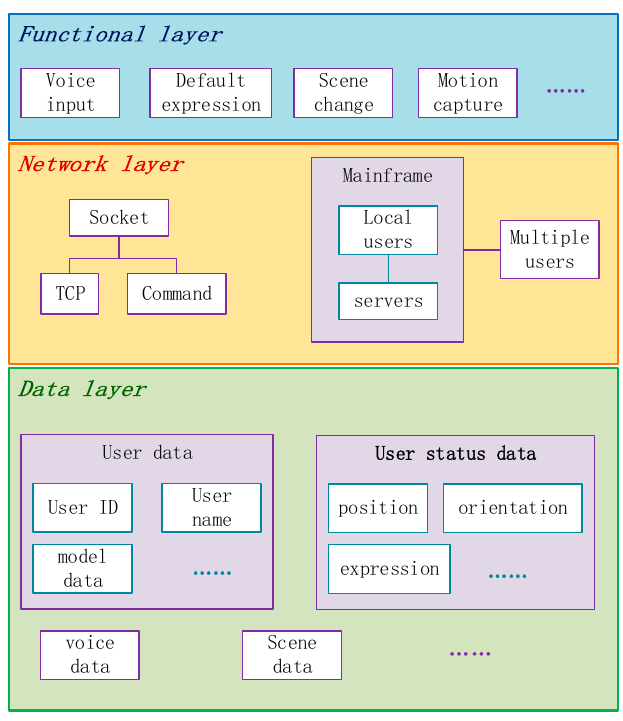
Figure 2. Main functions, network architecture, and underlying data classification of roaming, voice communication, motion capture immersive virtual reality social application (RVM-IVRSA).